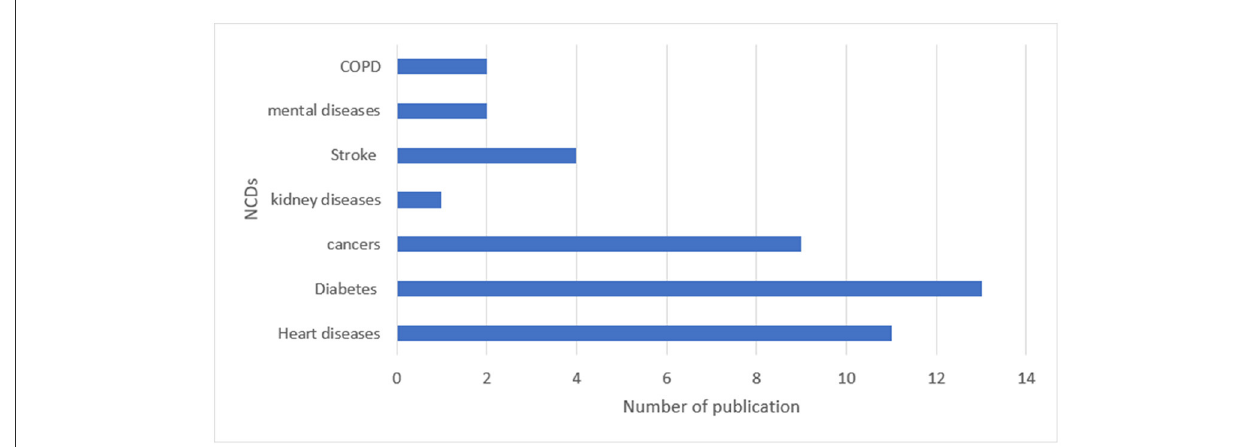
FIGURE4 Frequency distribution of publications focused on NCDs.